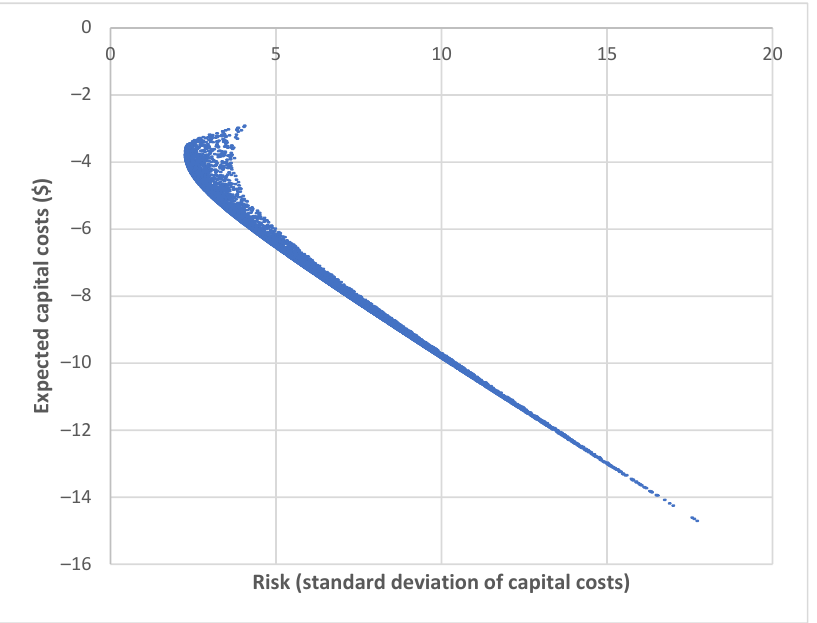
Figure 7. An illustrative efficient frontier for computing the weights of each project type to form the minimum variance portfolio based on 10,000 simulations using MPT.